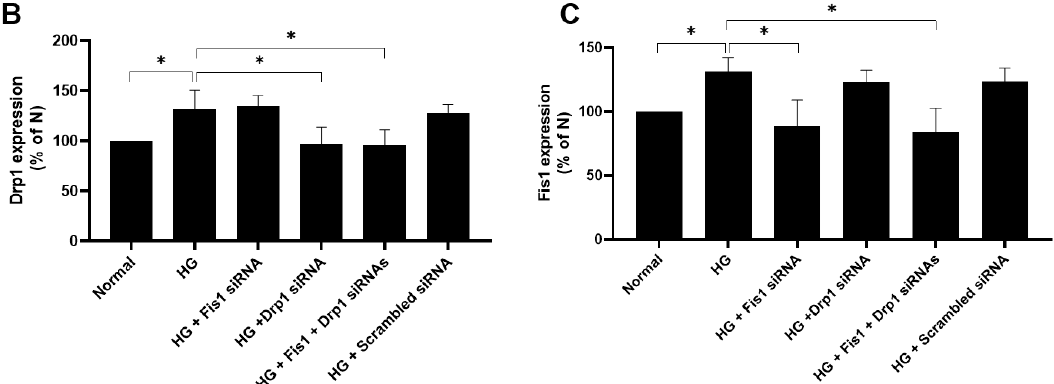
Figure 1. Effect of Fis1/Drp1 siRNA on high glucose (HG)-induced overexpression of Fis1 and Drp1 expression in rat retinal endothelial cells (RRECs). ( A ) Representative Western blot (WB) image shows Fis1 and Drp1 expression is significantly upregulated in cells grown in HG medium. In parallel, cells grown in HG and transfected with Fis1 siRNA, Drp1 siRNA, or both siRNAs showed corresponding decreases in Fis1 or Drp1 expression. Graphical illustration of cumulative data shows Drp1 ( B ) and Fis1 ( C ) are significantly upregulated in cells grown in HG condition and reduced in cells transfected with Drp1 and Fis1 siRNAs. Data are expressed as mean ± SD. * p < 0.05. n = 6.